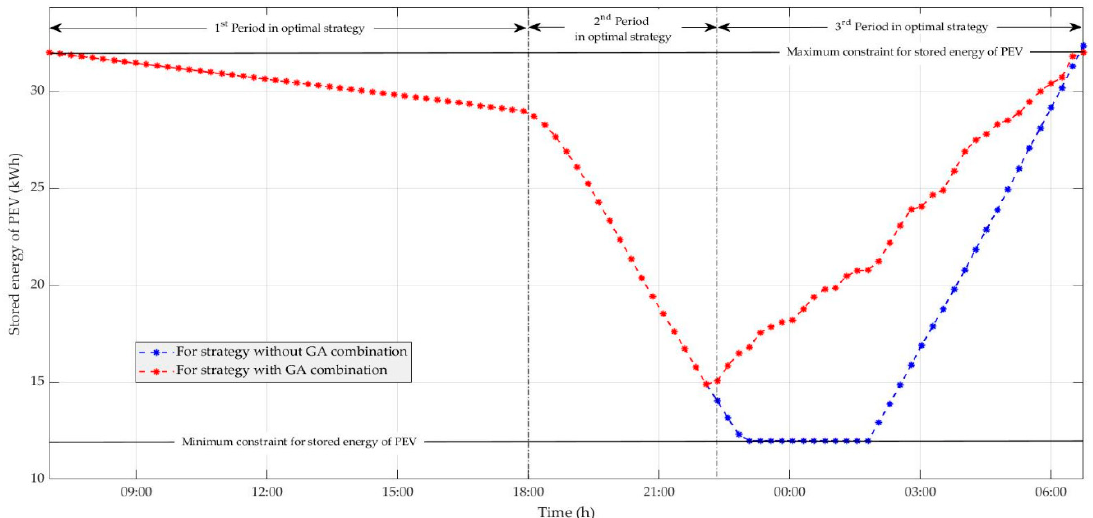
Figure 14. Comparison of stored energy of the PEV using strategies with and without the GA.